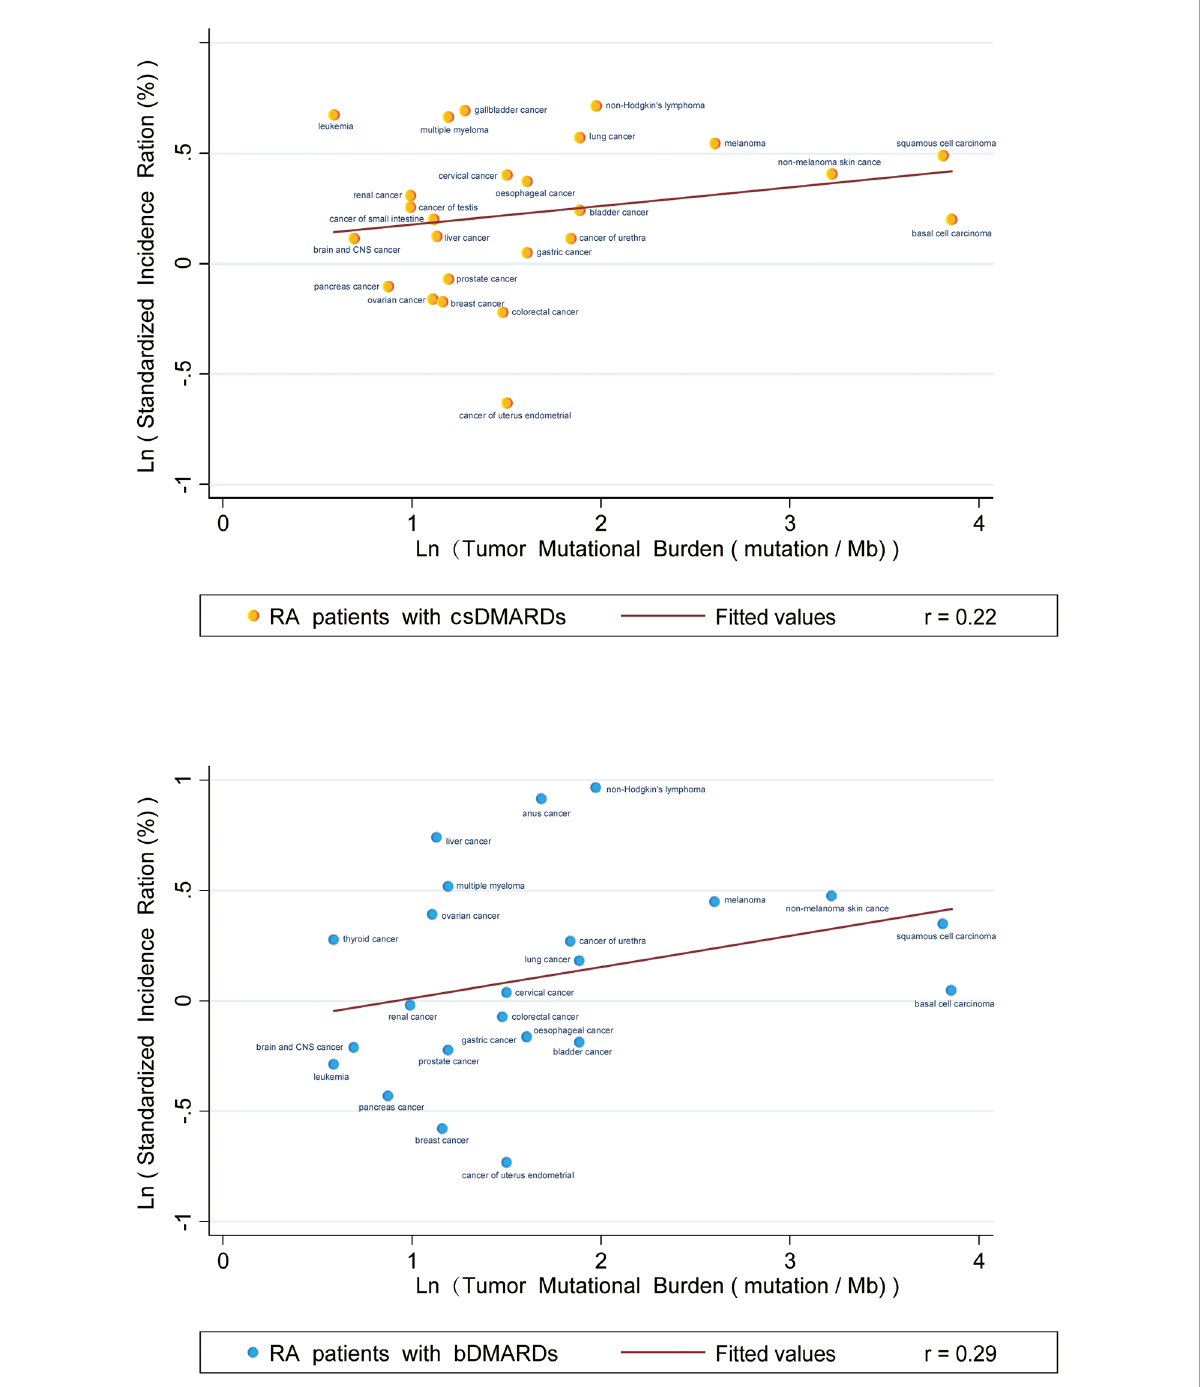
FIGURE 2 Correlation between Tumor Mutational Burdens and Standardized Incidence Ratios in RA patients taking CSDMARDs or bDMARDs. Data on the x and y axis are shown on a logarithmic